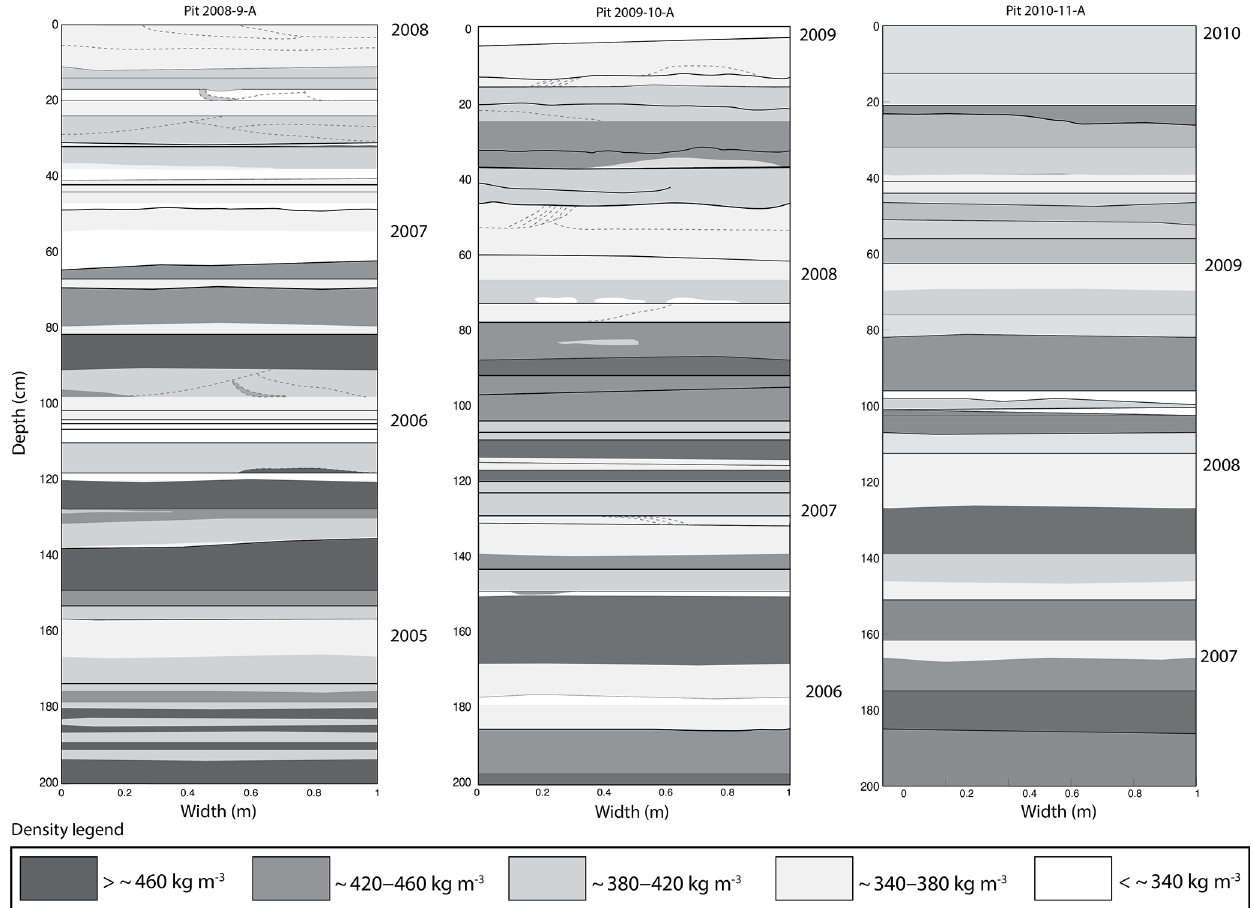
Figure 12. Complete wall maps of backlit snow pits prepared during 2008–2009, 2009–2010, and 2010–2011 WAIS Divide field seasons. Layering and density contrast are noted by degree of shading. Fine- to medium-grained, higher-density snow layers are shown with darker grey coloring, whereas coarse-grained and low-density layers (e.g., depth hoar) are shown in white. Crusts are indicated with solid lines, while dotted lines are used to represent cross-bedding at depth. Years were identified based on approximate depths of peak summers and the average measured densities. The pit wall surfaces trend in parallel with the prevailing wind direction at WAIS Divide (approximately north–south, with north to the